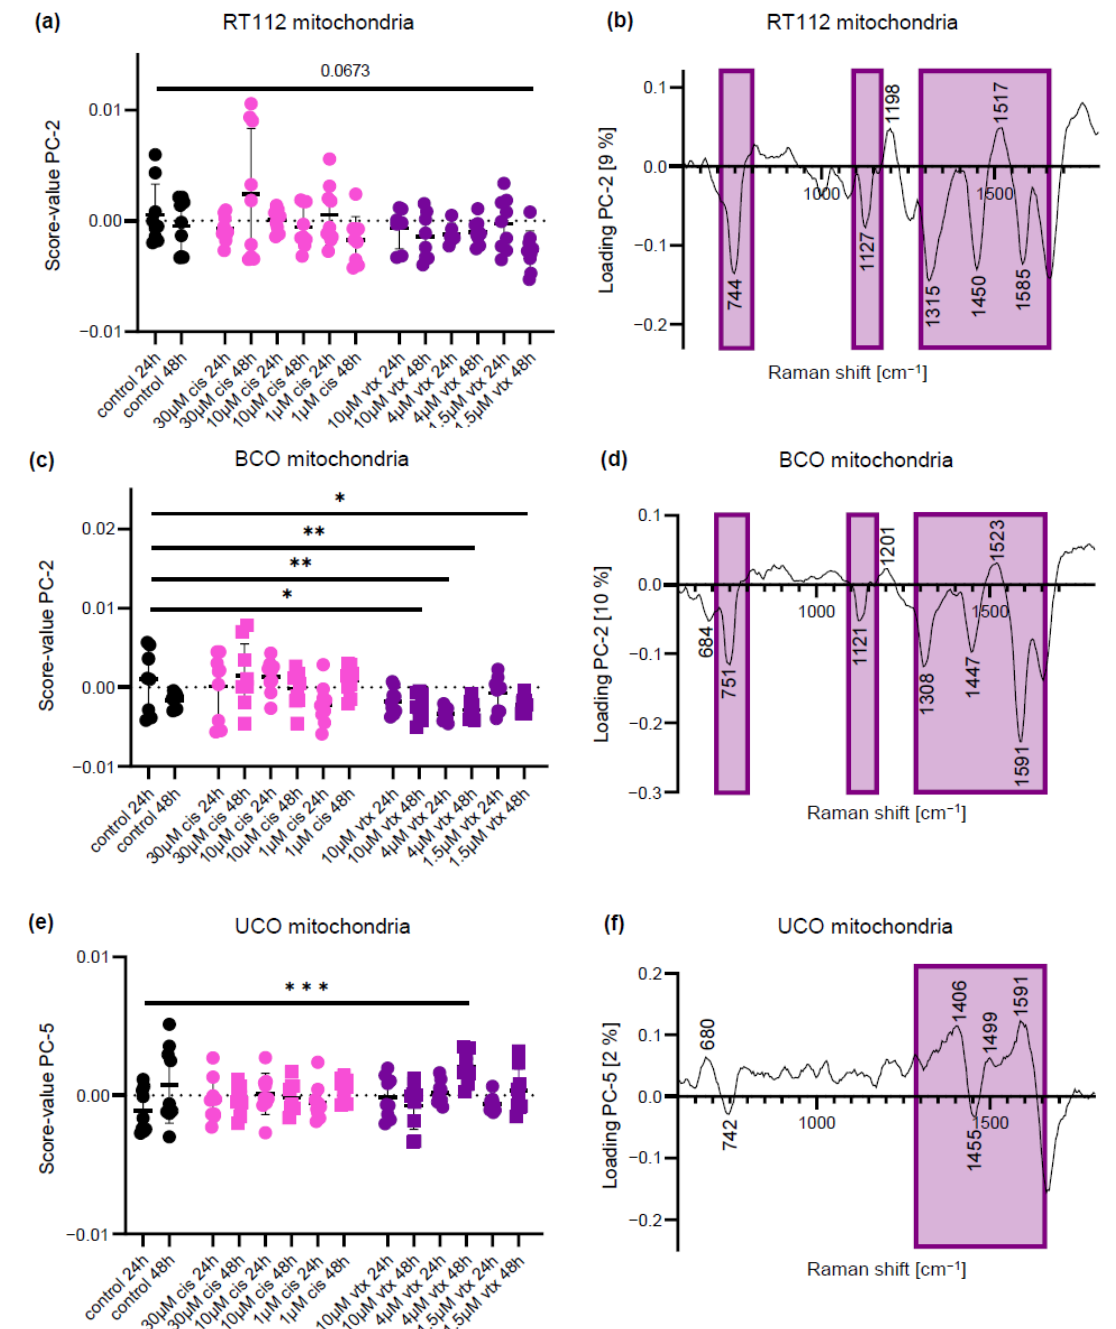
Figure 3. PCA of mitochondria-derived Raman spectra reveals similar spectral for all organoid models after vtx (purple) treatment. ( a ) Score value analysis of organoids from the cell line RT112 shows tendencies of separation after vtx treatment. ( b ) Corresponding loading plot. ( c ) Score value analysis of patient-derived BCOs show statistically significant differences after vtx . ( d ) Correspond- ing loading plot. ( e ) Score value analysis of patient-derived UCOs reveals statistically significant differences between controls and vtx treatment. ( f ) Corresponding loading plot. Black: controls; pink: cis treatment; purple: vtx treatment; circles: 24 h; square: 48 h; Statistical analysis: One-way ANOVA, n = 9, * p < 0.05, ** p < 0.01, *** p <